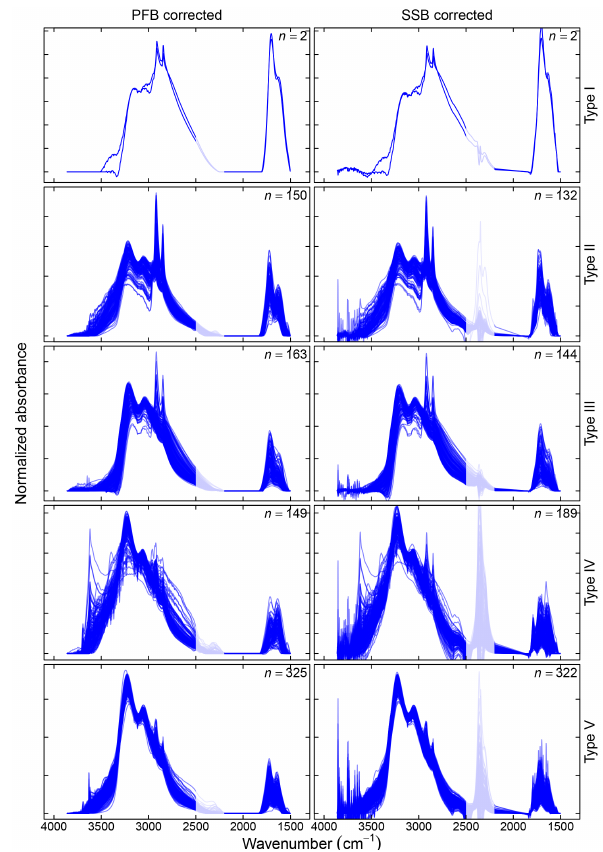
Figure 7. Cluster membership for polynomial and smoothing splines methods. The region between 2500 and 2200cm − 1 is masked to indicate the region of CO 2 absorption not associated with aerosol